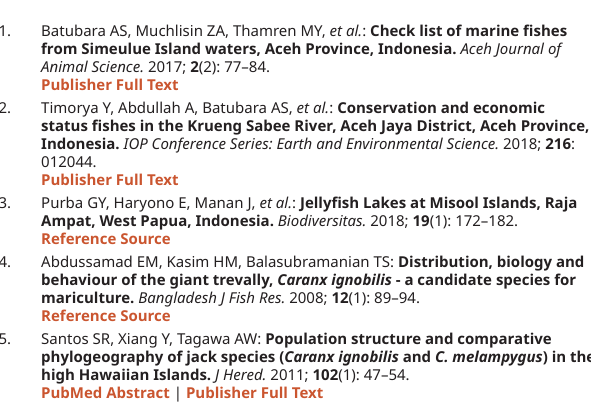
Figshare: Supplementation of rice husk activated charcoal in feed and its effects on growth and histology of the stomach and intestines from giant trevally Caranx ignobilis , https://doi.